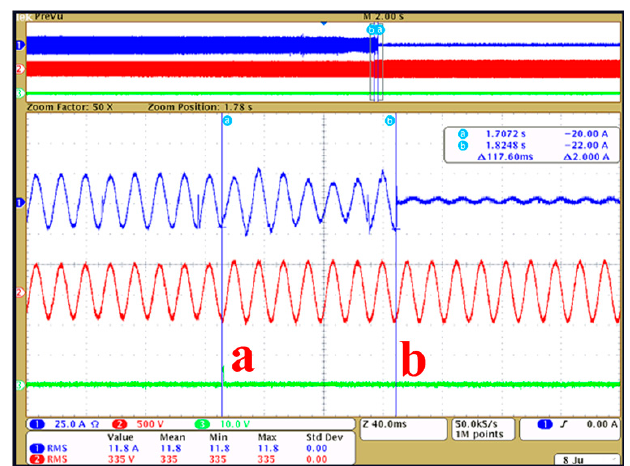
Figure 14. Microgrid system response in islanded more of operation for sudden low frequency operating condition.